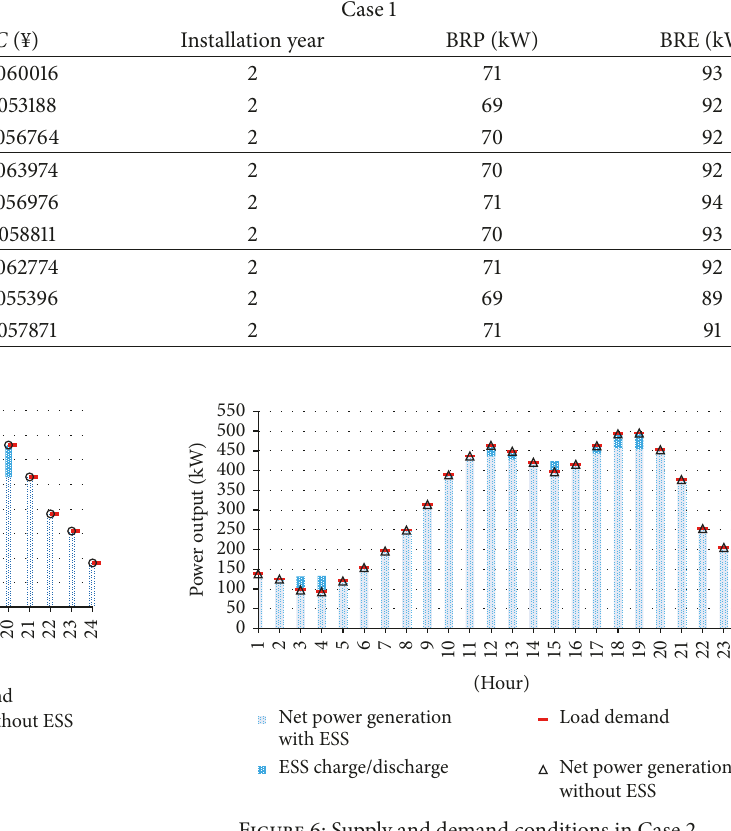
Figure 6: Supply and demand conditions in Case 2.